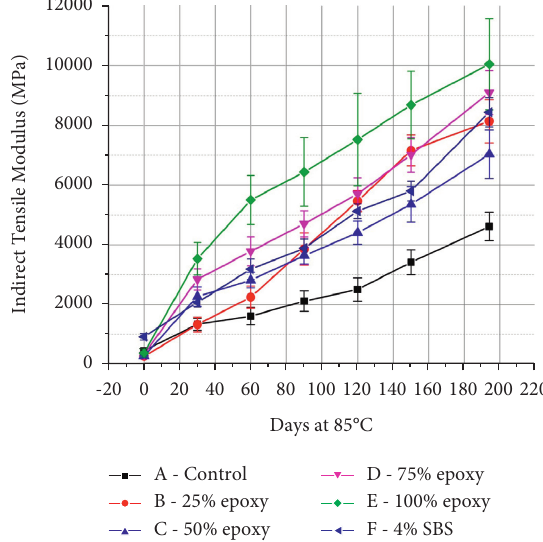
Figure 31: Resilient modulus for open-graded mixture with neat asphalt, SBA, and EA [18].